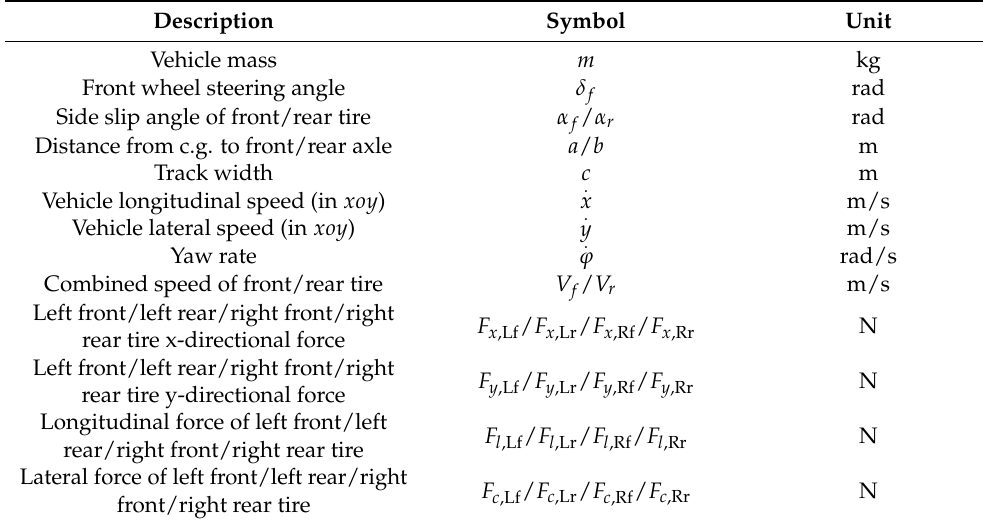
Table 1. Definitions and symbols in dynamical model. Description Symbol Unit Vehicle mass m kg Front wheel steering angle δ f rad Side slip angle of front/rear tire α f / α r rad Distance from c.g. to front/rear axle a / b m Track width c m . x m/s Vehicle longitudinal speed (in xoy ) . y m/s Vehicle lateral speed (in xoy ) . Yaw rate ϕ rad/s Combined speed of front/rear tire V f / V r m/s Left front/left rear/right front/right F x ,Lf / F x ,Lr / F x ,Rf / F x ,Rr N rear tire x-directional force Left front/left rear/right front/right F y ,Lf / F y ,Lr / F y ,Rf / F y ,Rr N rear tire y-directional force Longitudinal force of left front/left F l ,Lf / F l ,Lr / F l ,Rf / F l ,Rr N rear/right front/right rear tire Lateral force of left front/left rear/right F c ,Lf / F c ,Lr / F c ,Rf / F c ,Rr front/right rear tire